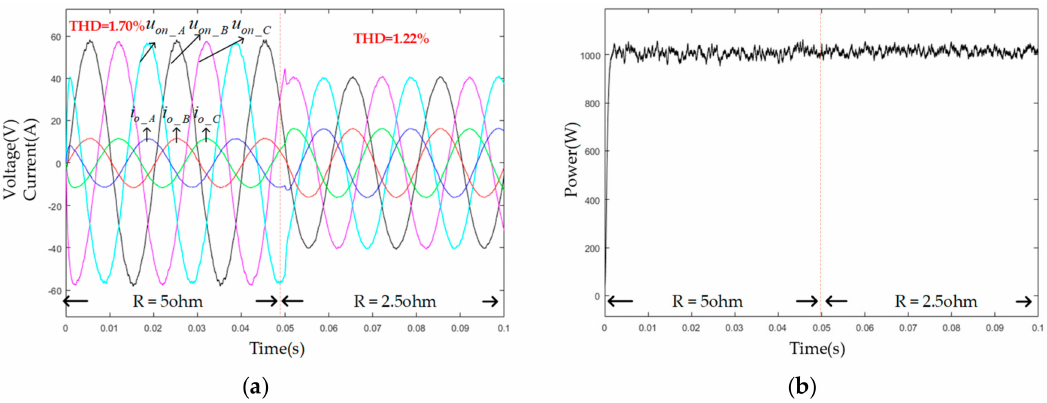
Figure 15. PR simulation result under DC load mode. ( a ) voltage and current; ( b ) output power.